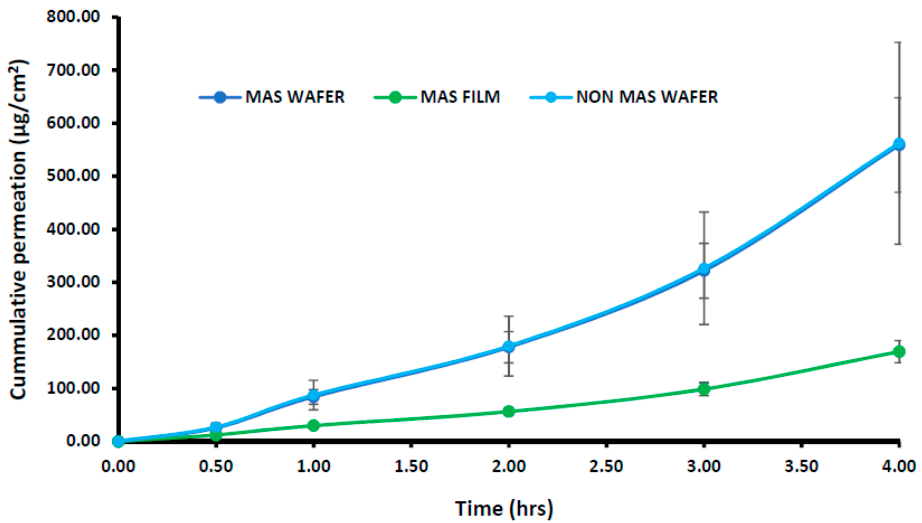
Figure 9. Cumulative permeation of optimized wafers and films using EpiOral TM engineered buccal tissue ( n = 3, ± SD).